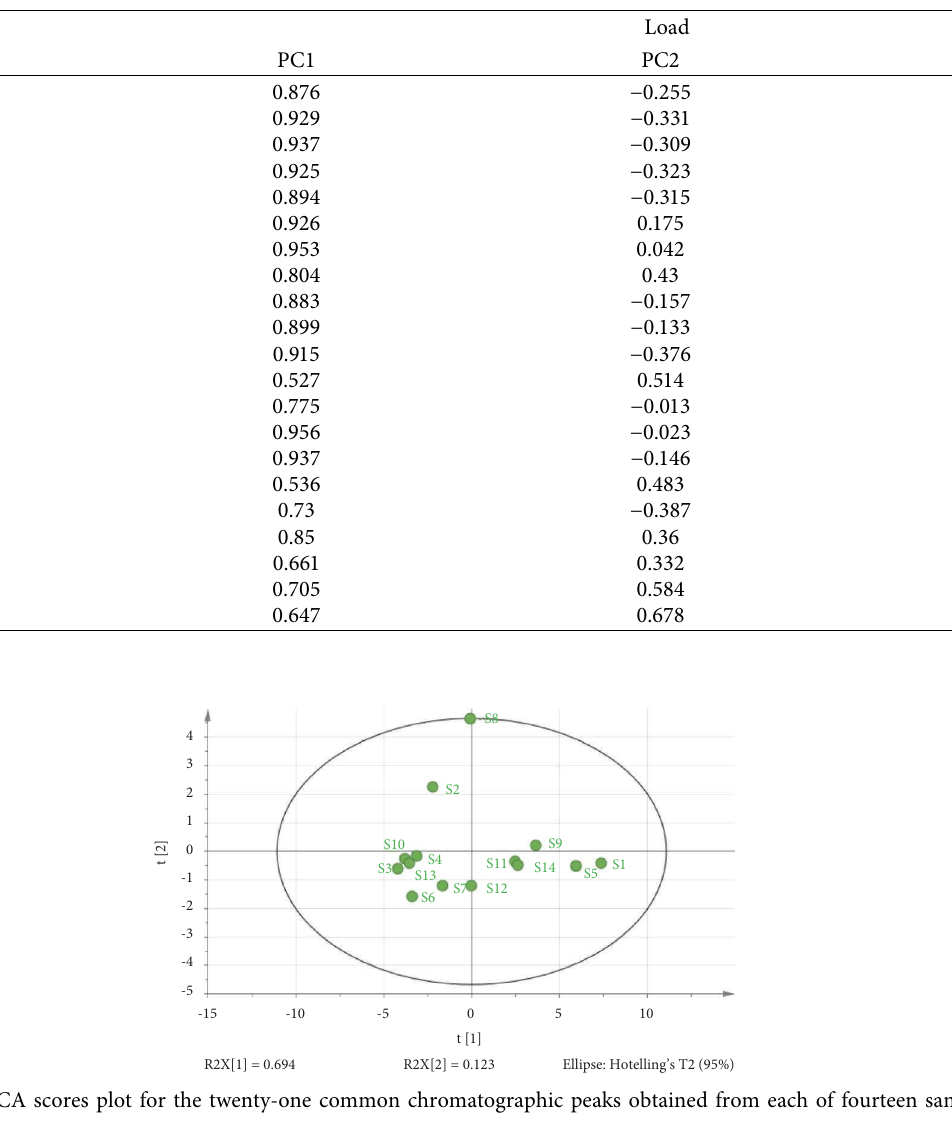
Table 10: Loading matrix analysis results of 21 common peak principal components in 14 samples.